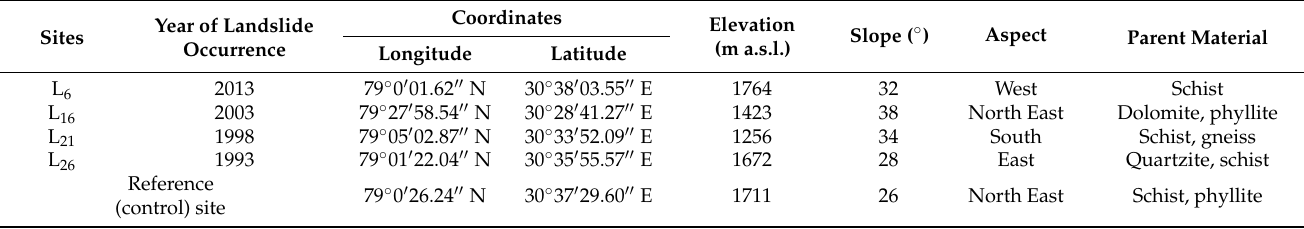
Table 1. Characteristics of studied landslide sites and reference (control) site in Garhwal